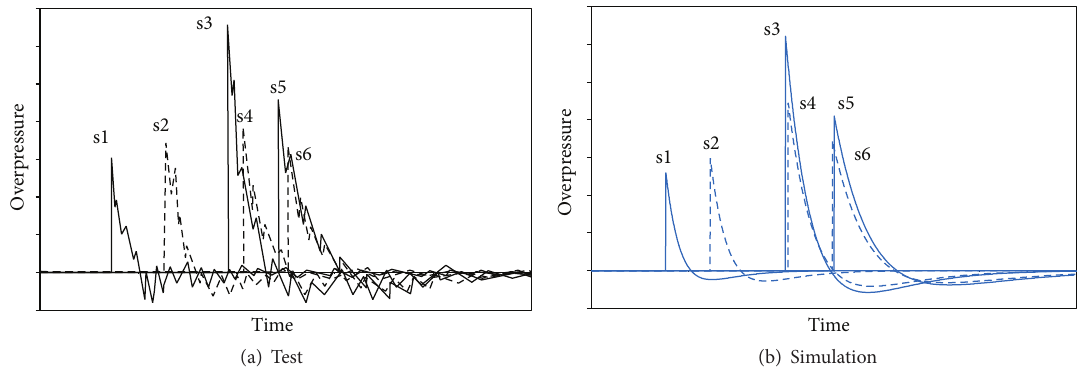
Figure 5: Overpressure versus time curves of pressure sensors in test (a) and simulation (b) with similar axes scale.